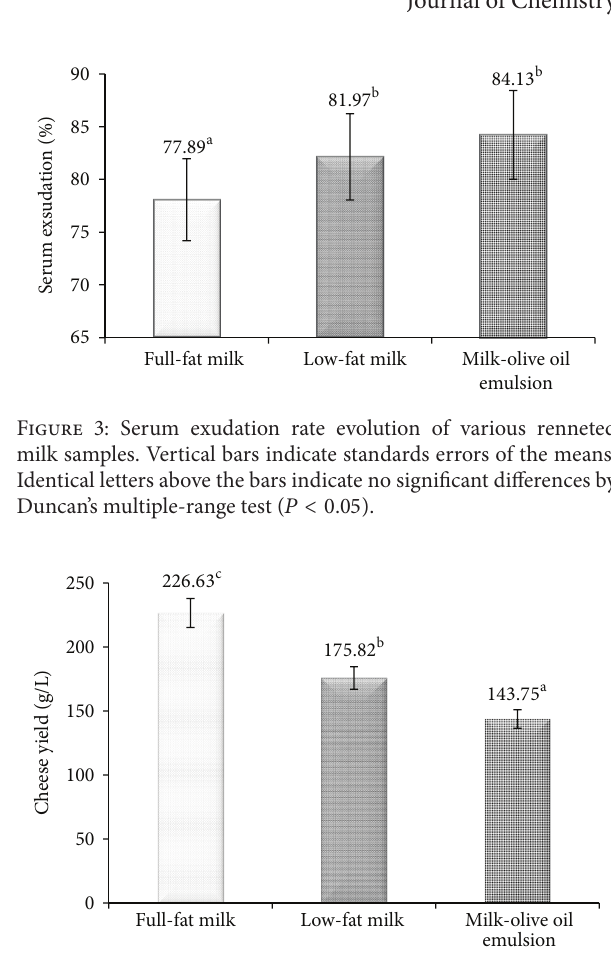
Figure 4: Cheese yields of various renneted milk samples (g/L). Vertical bars indicate standards errors of the means. Identical letters above the bars indicate no significant differences by Duncan’s multiple-range test ( 𝑃 < 0.05